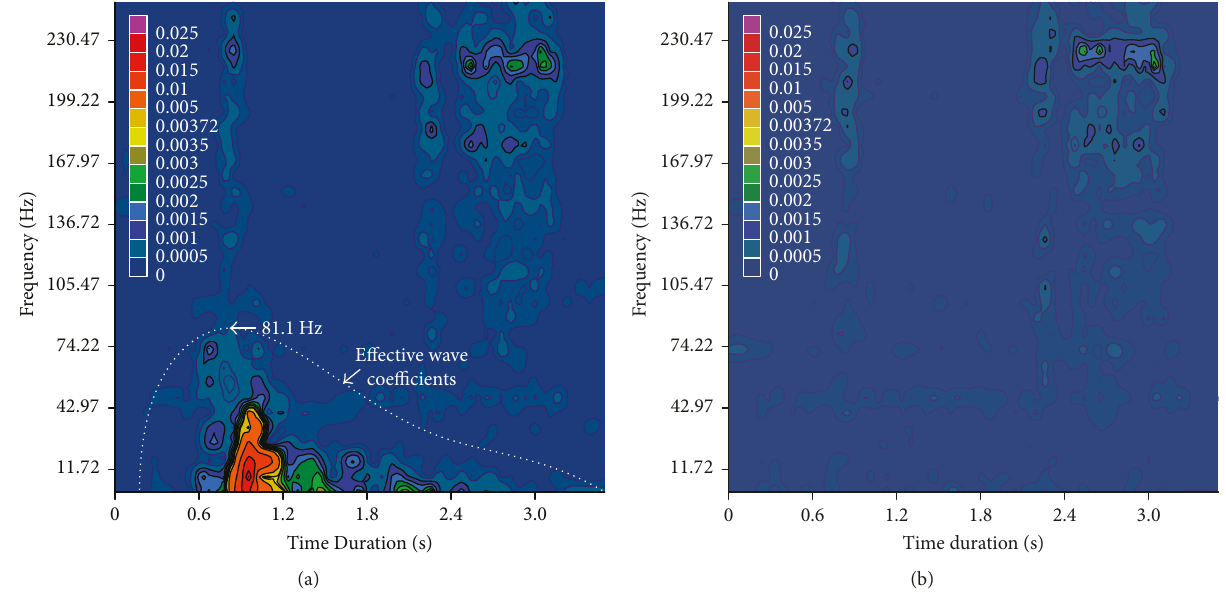
Figure 9: Coefficient magnitude distribution of the monitored microseismic wave and the reference noise in the time-frequency conjoint domain after performing the wavelet packet transform using the basis sym5 at level 5.